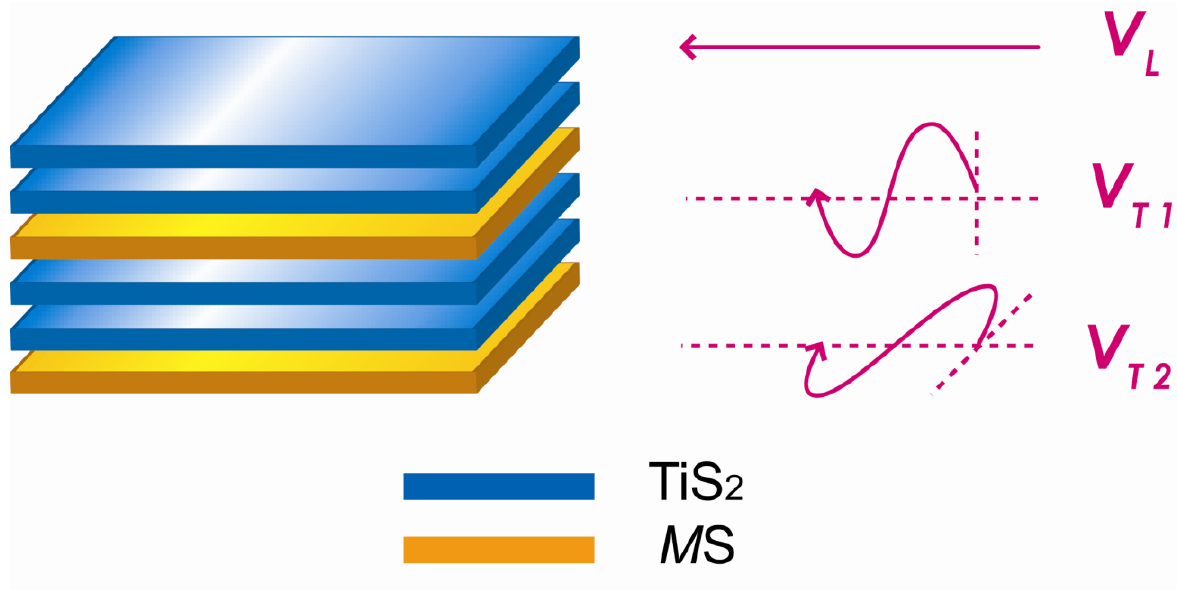
Figure 10 . Schematic illustration of the longitudinal and transverse sound velocities of the layered ( M S) (TiS ) compounds. 1+x 2 2